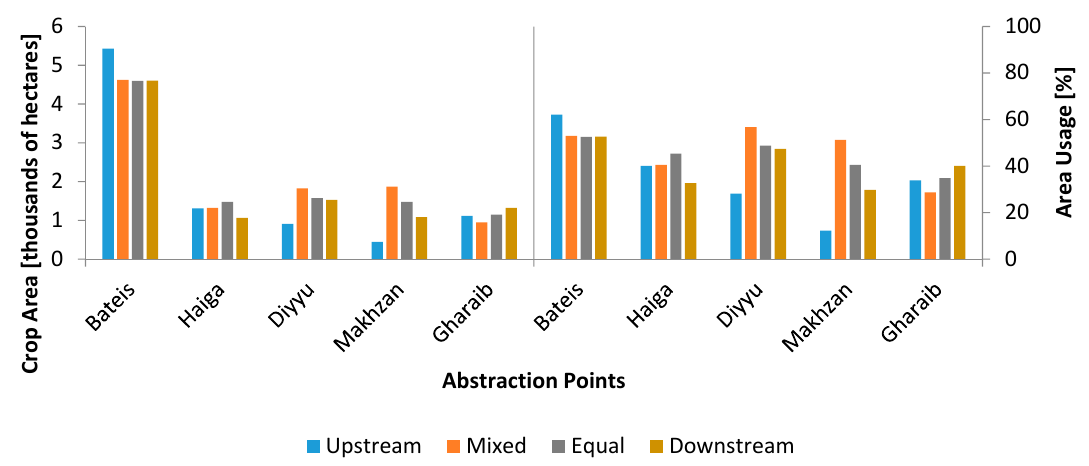
Figure 7. Cropping area used under the different water allocation scenarios.